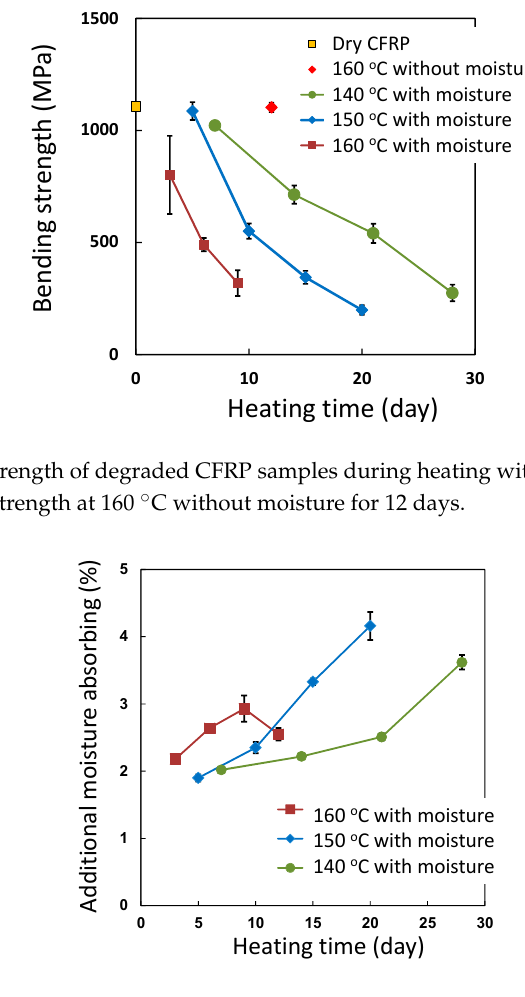
Figure 11. The additional moisture absorbing of degraded CFRP samples during heating with moisture at 140, 150 and 160 °C and moisture content at 120 °C with moisture (quick moisture saturated condition).